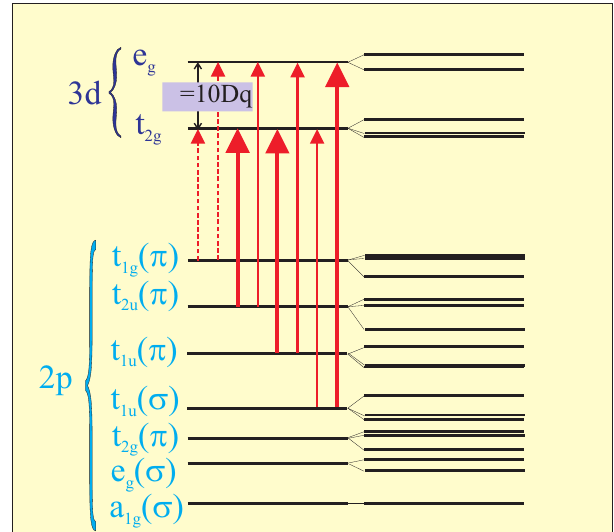
Figure 1. The diagram of Me3d-O2p molecular orbitals for the MeO 6 octahedral center. The O2p- Me3d charge transfer transitions are shown by arrows: strong dipole-allowed σ − σ and π − π by thick solid arrows; weak dipole-allowed π − σ and σ − π by thin solid arrows; weak dipole-forbidden low-energy transitions by thin dashed arrows. Adapted from reference